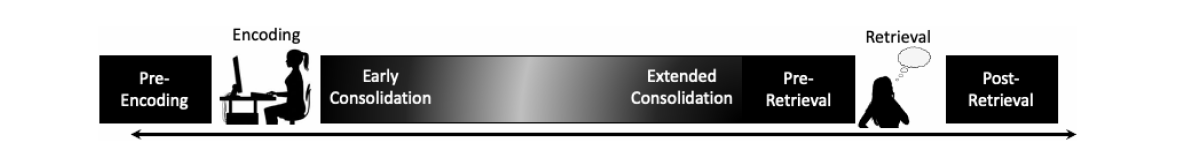
FIGURE1 Schematic of the five stages of long-term episodic memory processing during which sleep can be manipulated: (1) prior to encoding, (2) immediately following encoding during early consolidation, (3) during extended consolidation away from initial learning, (4) just prior to retrieval of emotional memory, and (5) post-retrieval/reconsolidation.